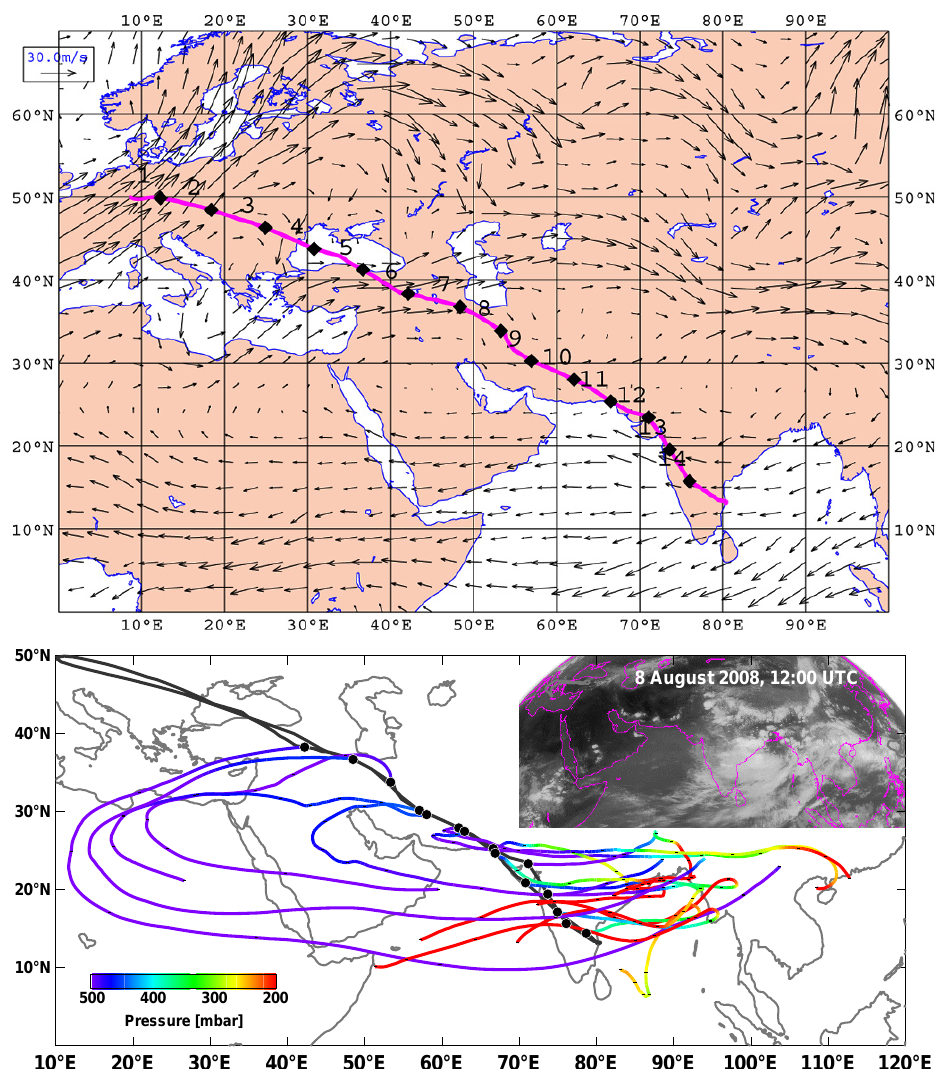
Fig. 2. (a) Wind field at 250hPa on 13 August 2008 for a flight from FRA to MAA. Direction is indicated by the arrows, which increase in size with wind speeds. The solid line is the flight path and markers denote whole air sampling locations. (b) Backward trajectories for the air samples collected within the monsoon circulation during the August 2008 flight. Markers along the trajectories indicate 24h periods. Inset is a satellite image of cloud cover over the region at 12:00UTC on 8 August 2008, 5 days prior to the flight (SSEC,